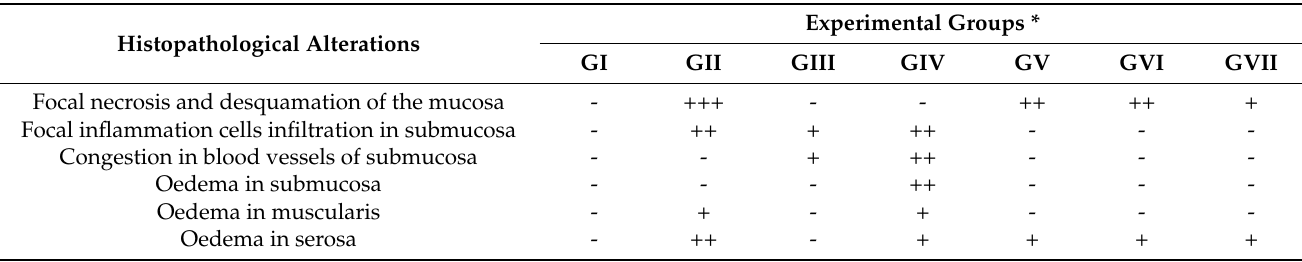
Table 7. The severity of histopathological alteration and underlying structure of stomach of different experimental groups, n = 6.